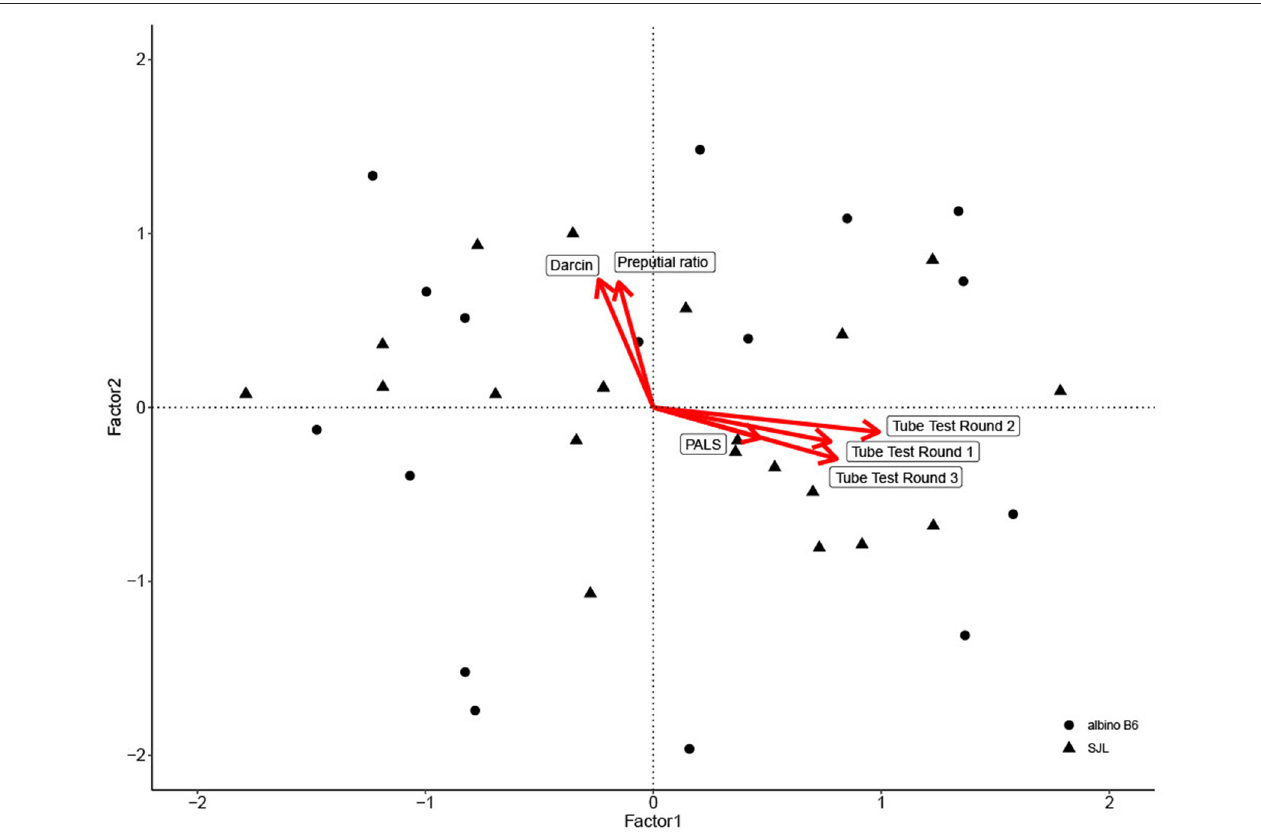
FIGURE 2 | Biplot of factor analysis used to assess convergent validity. Individual data point scores are plotted along Factor 1 and Factor 2, with shape based on strain. Variable loadings for each factor are depicted by red